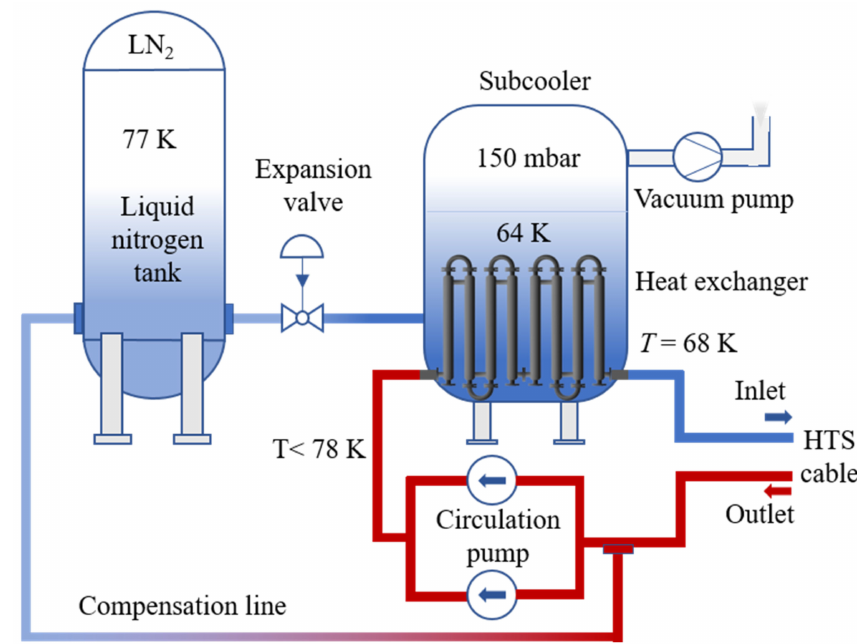
Figure 6. Simplified diagram of the different components of the cooling